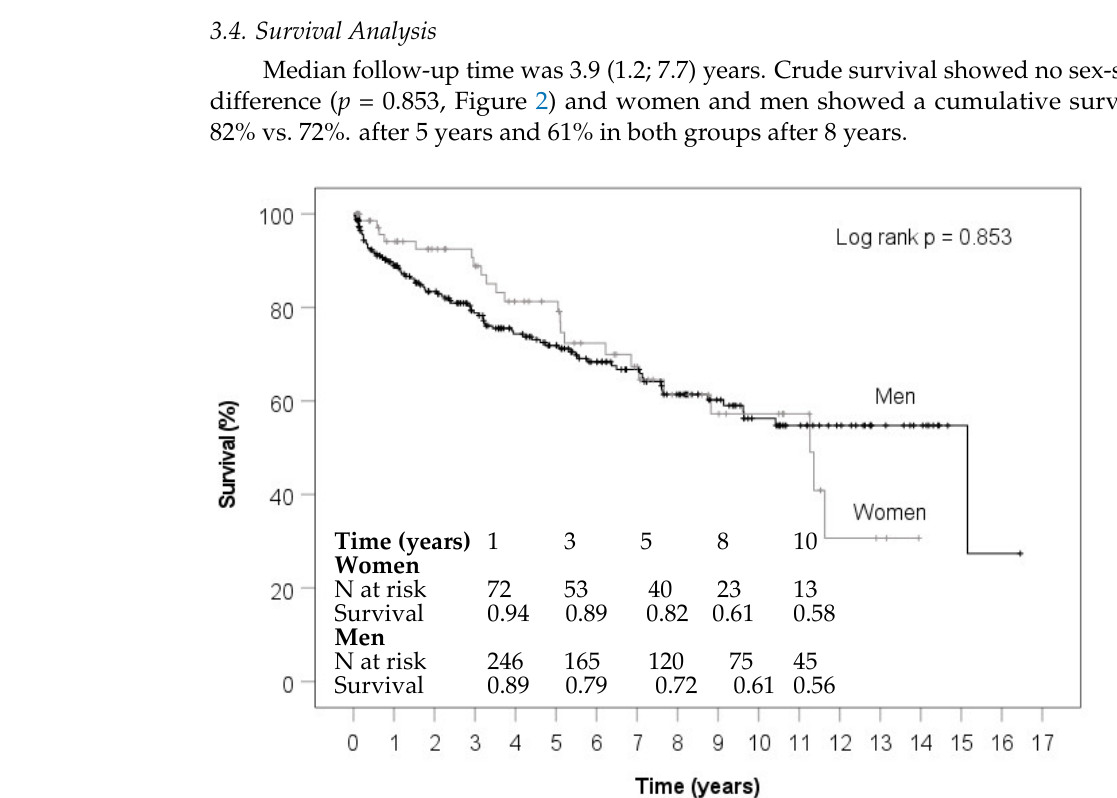
Figure 2. Survival of women and men during follow-up. 3.5. Risk Factors for Long-Term Survival Female gender did not prove to be a risk factor for mortality during follow-up ( p = 0.718, Table